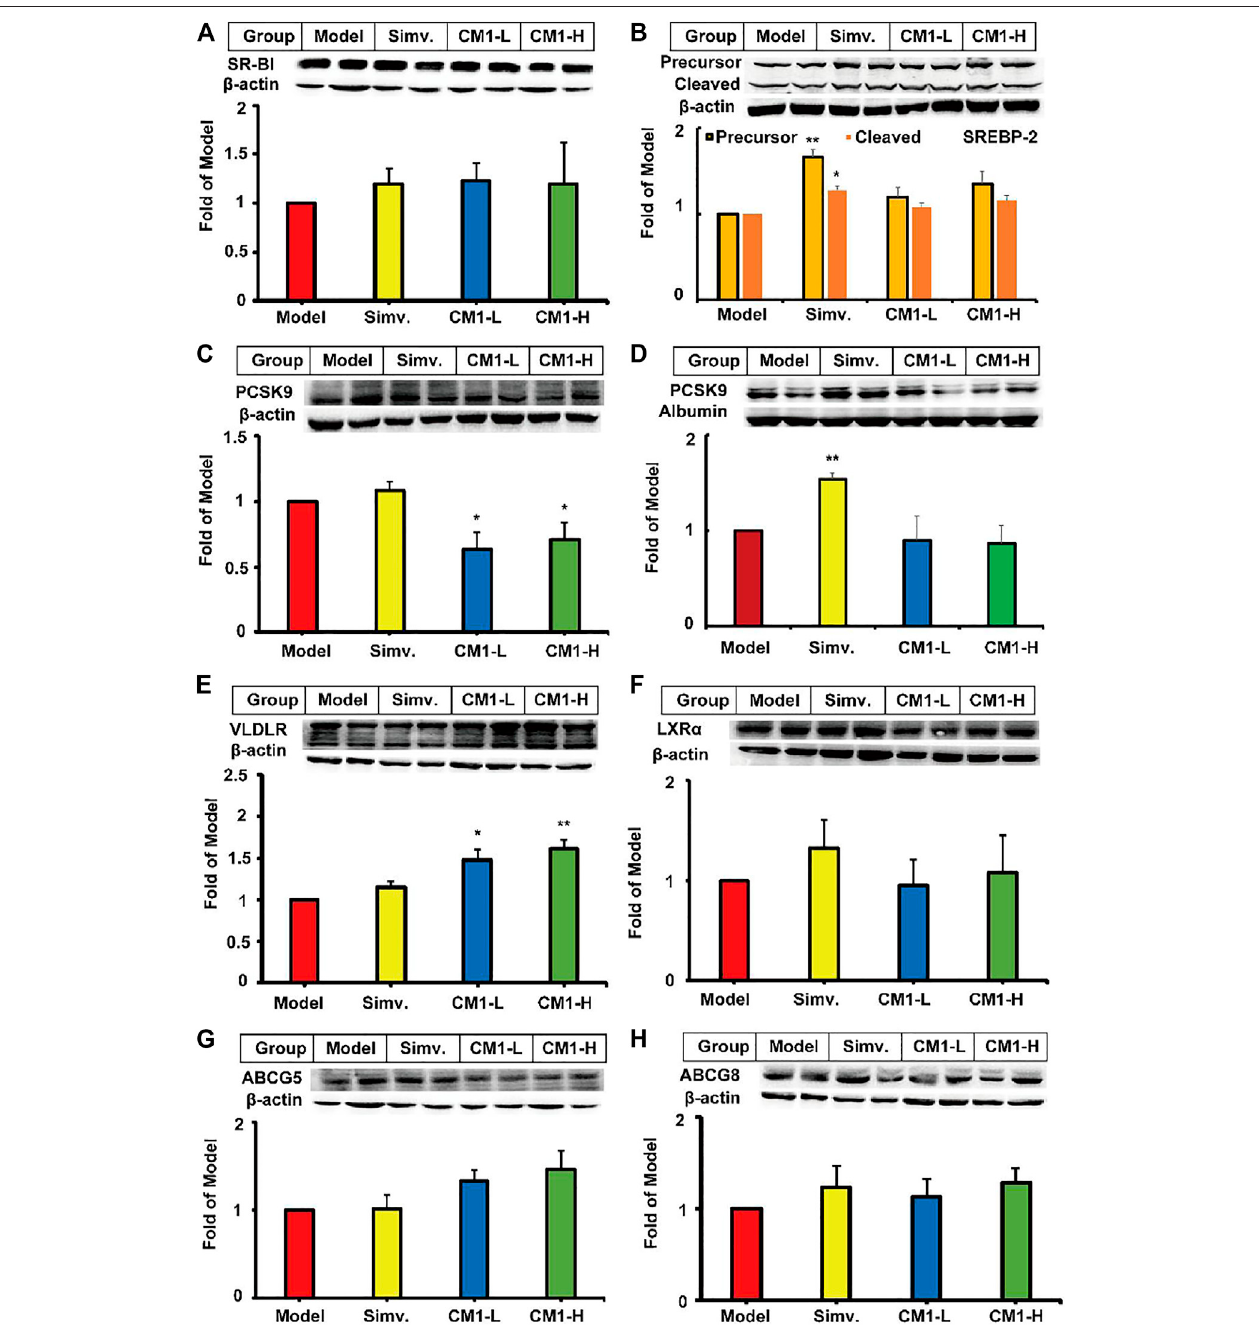
FIGURE3| EffectofCM1onTCmetabolismrelatedproteinsintheliverandplasmaoftheLDLR (-/-) mice( n ≥ 4).Proteinexpressionanddensitometricquanti fi cation (A) , SR-B1 in the liver; (B) , SREBP-2 in the liver, precursor ( ∼ 125 kDa) and the cleaved mature form ( ∼ 68 kDa); (C) , PCSK9 in the liver; (D) , PCSK9 in the plasma; (E) , VLDLR in the liver; (F) , LXR α in the liver; (G) , ABCG5 in the liver; (H) , ABCG8 in the liver. *means p < 0.05 vs . Model, and **means p < 0.01 vs . Model.